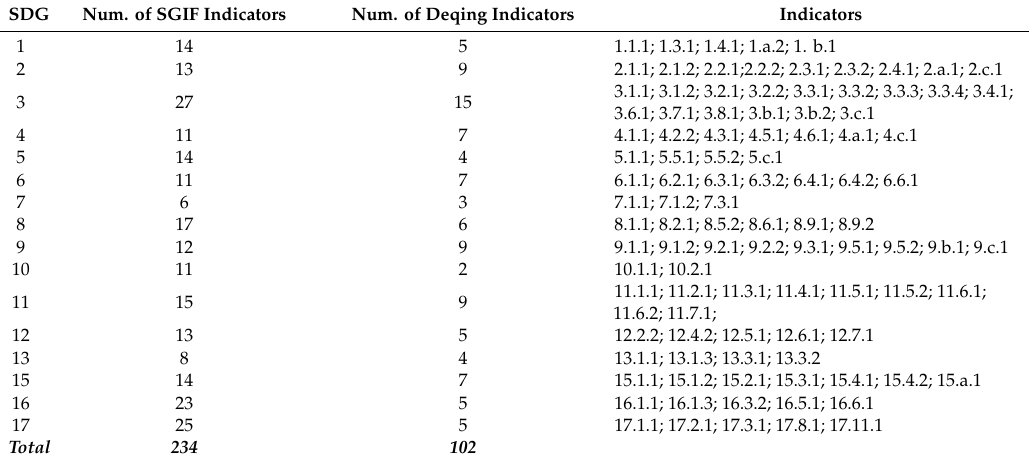
Table 1. The 102 indicators used for the Deqing study